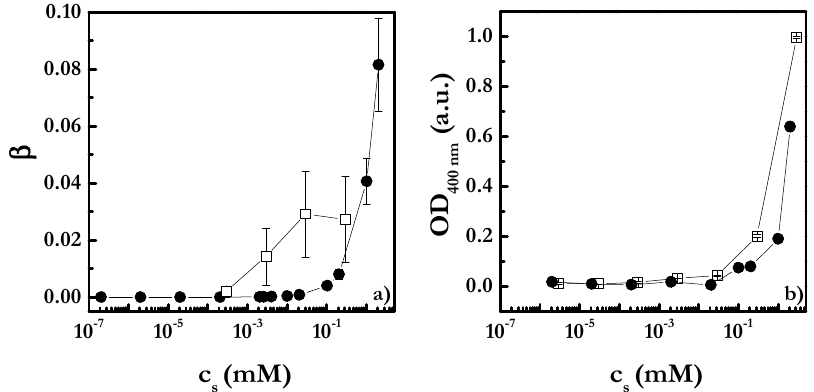
Figure 1. ( a ) Binding isotherms for surfactants on PDADMAC as a function of the initial concentration of surfactant in bulk. ( b ) Surfactant concentration dependences of the optical density of the solution, measured at 400 nm. Note: ( □ ) = PDADMAC-SLMT; ( ● ) = PDADMAC-SLES solutions. Lines are guides for the eyes. The results correspond to PDADMAC-surfactant mixtures containing a fixed PDADMAC concentration of 0.5 wt.%, and left to age for one week prior to measurement.